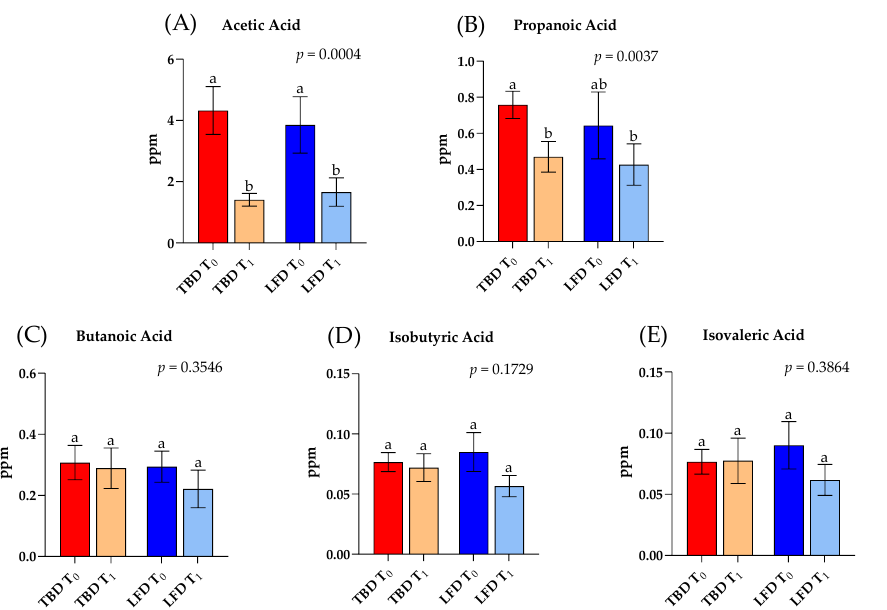
Figure 5. Significant (adjusted p < 0.05) concentrations (ppm) of short-chain fatty acids (SCFAs) and branched-chain fatty acids (BCFAs) in headspace fecal samples of IBS-D patients before (T 0 ) and after (T 1 ) TBD and LFD. Data are expressed as mean (M) ± standard error of the mean (SEM). Statistical differences were obtained by the Kruskal–Wallis test and corrected by Dunn’s multiple Test. Different letters differ significantly ( p < 0.05). Abbreviations: IBS-D, irritable bowel syndrome with diarrhea; LFD, low-FODMAPs diet; TBD, tritordeum-based diet.